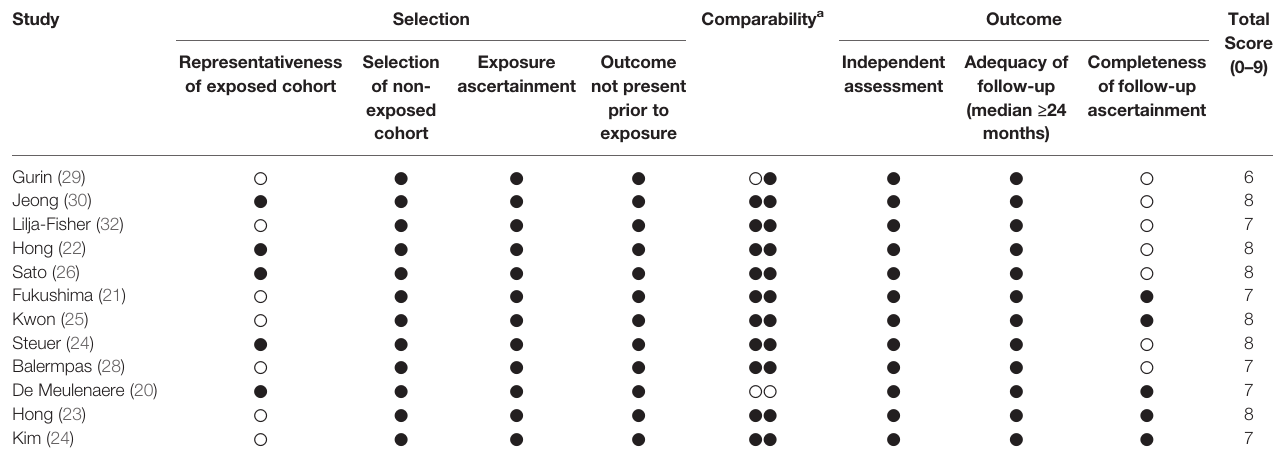
TABLE 2 | Quality assessment of included studies according to the Newcastle-Ottawa Scale (http://www.ohri.ca/programs/clinical_epidemiology/oxford.asp).